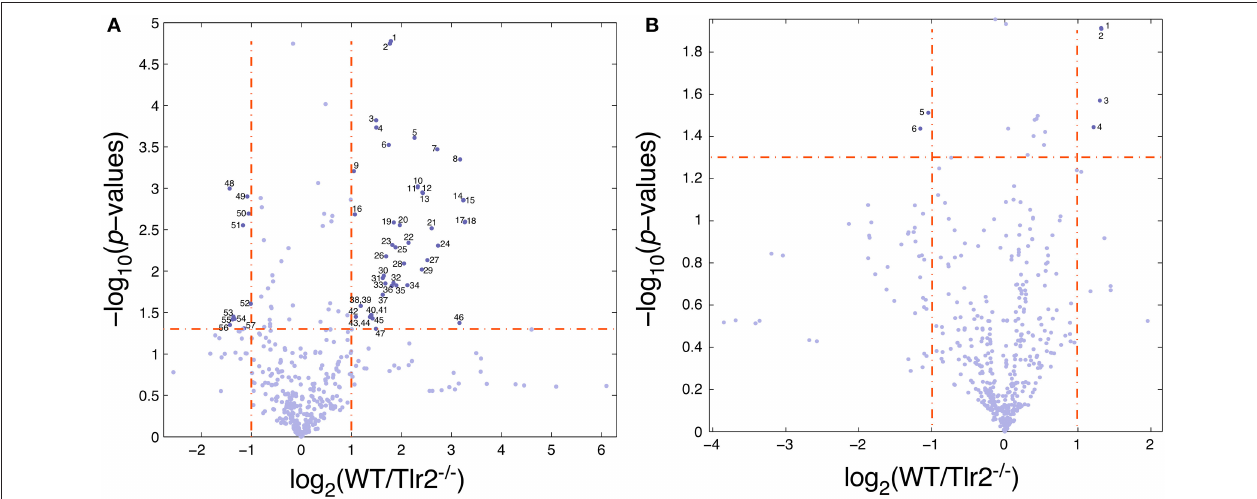
FIGURE 1 | Volcano plot of differentially expressed behaviors between wildtype and Tlr2 − / − cohorts (A) . 4–4.5 months old cohort. Generally, Tlr2 − / − mice demonstrated fewer behaviors overall during the circadian light cycle, and had altered active/inactive state properties. Dashed vertical lines depict boundaries for two-fold decreases (left) and increases (right) in behavior (WT compared to Tlr2 − / − ); dashed horizontal line depicts behavioral significance p < 0.05. Behaviors between the left and right dashed vertical lines show no significant differences between WT and Tlr2 − / − mice. Descriptions of identified behaviors are provided in columns A-C of Supplemental Table 1 . Abbreviations forming behavior names are as follows: AFL: activity-feeding-licking overall averages; TBA: time